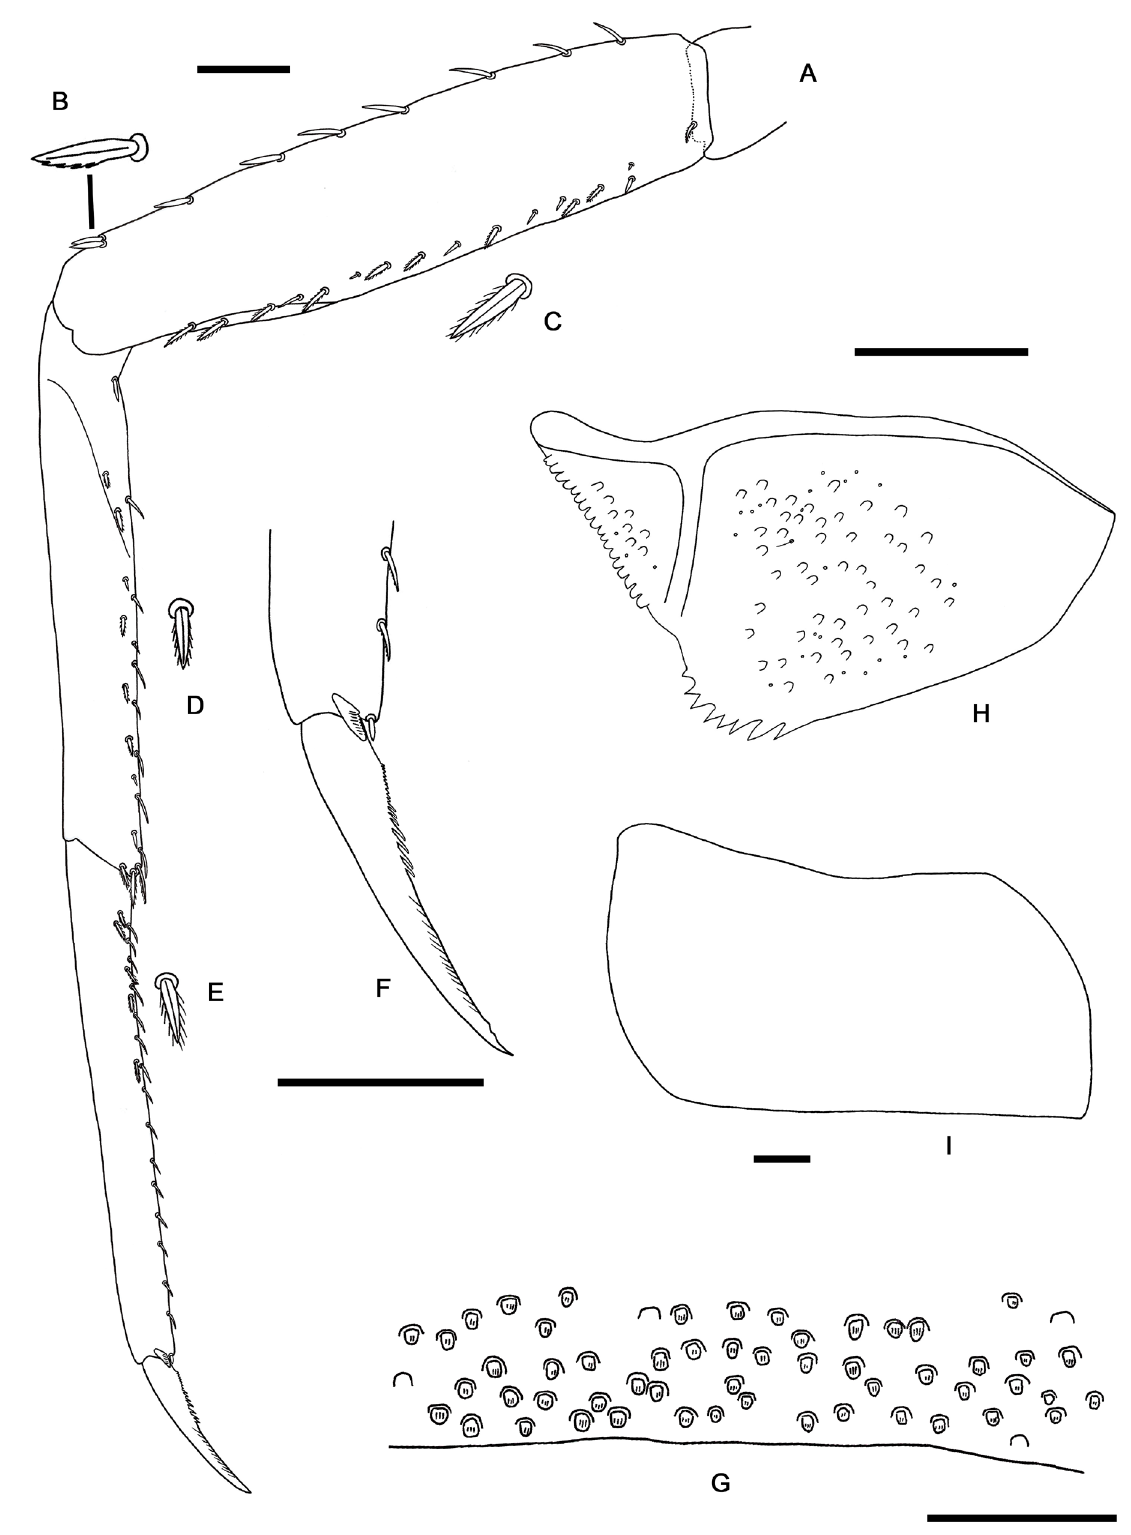
Fig. 2. Procerobaetis leptobranchius gen. et sp. nov., larval morphology. A . Foreleg. B . Seta at dorsal margin of femur (apex). C . Seta near ventral margin of femur. D . Seta at ventral margin and on ventral surface of tibia. E . Seta at ventral margin of tarsus. F . Fore claw. G . Tergum IV. H . Paraproct. I . Metanotum. Scale bars: 0.1